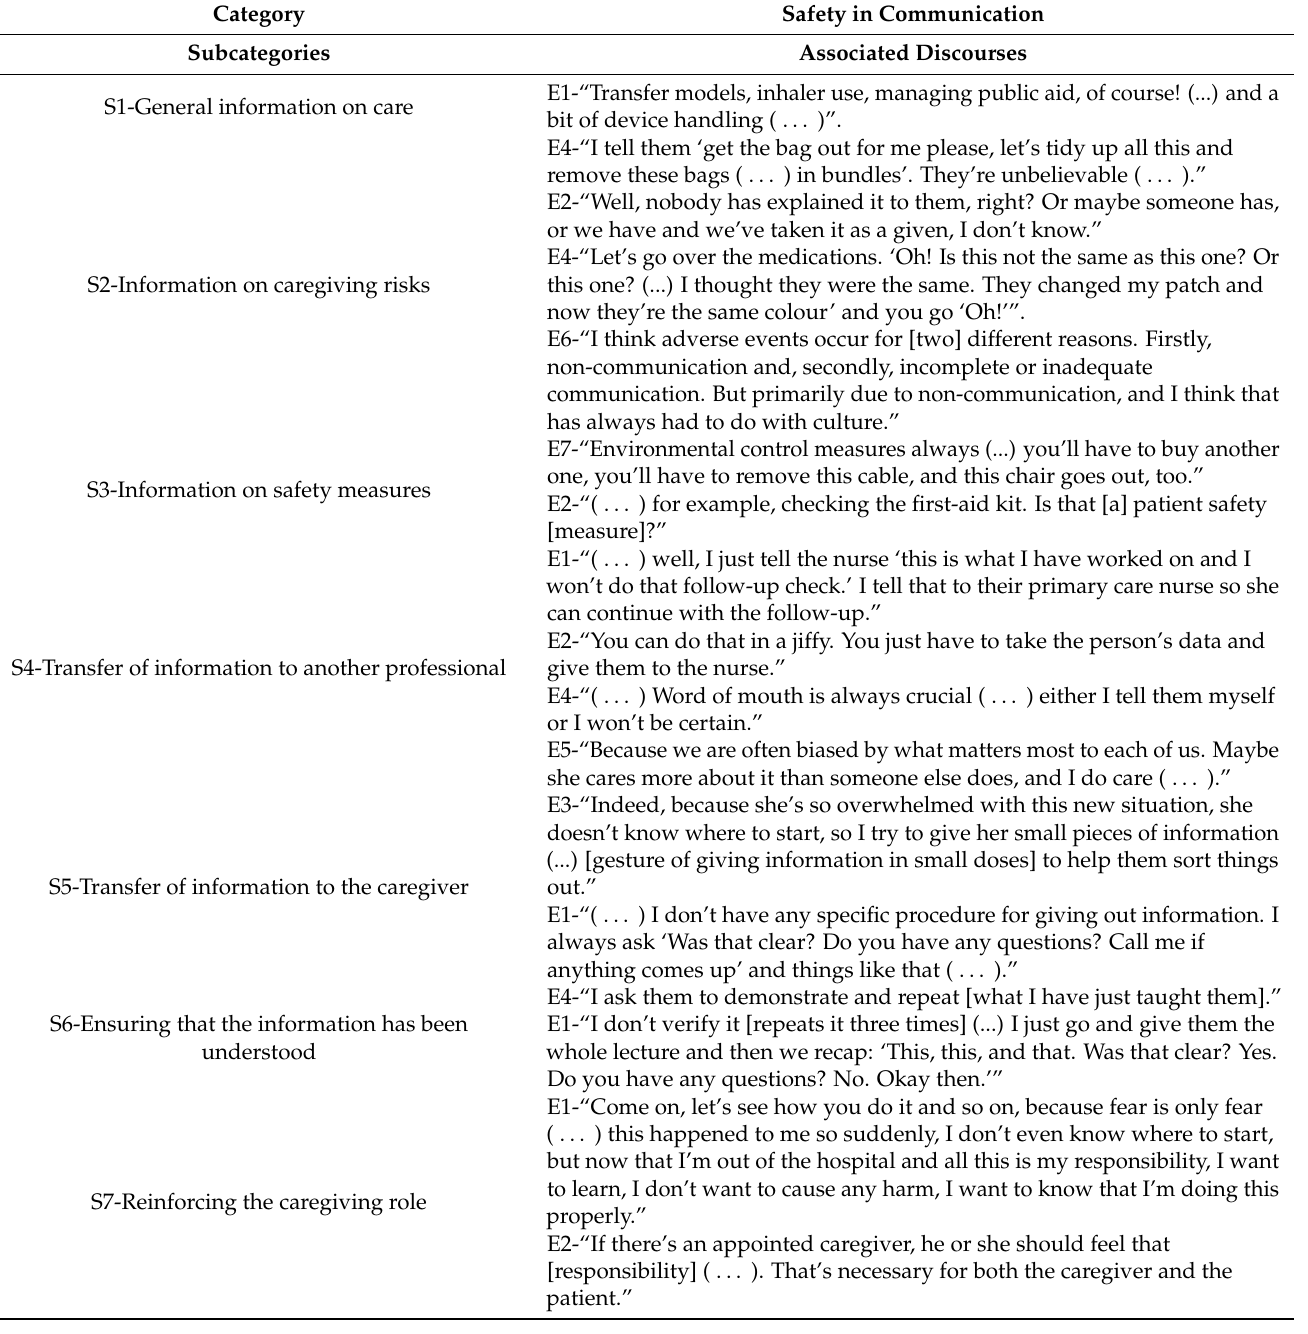
Table 4. Category S: Safety in